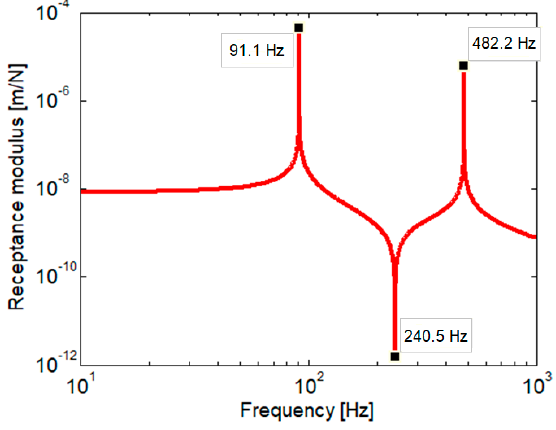
Figure 12. Rail receptance (homogeneous two-layer foundation). Materials 2023 , 16 , x FOR PEER REVIEW 18 of 24